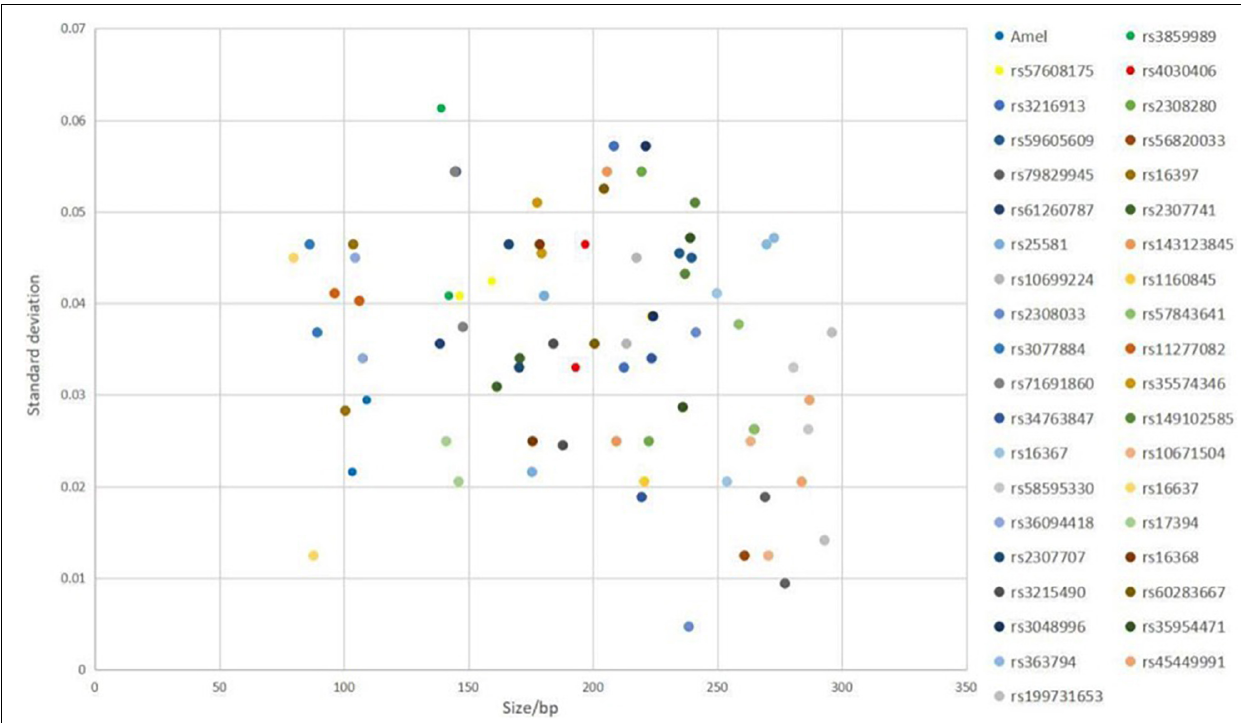
FIGURE 3 | Size precision study of AGCU X-InDel 38 kit was performed on 3130XL Genetic Analyzer. The X -axis represents the fragment sizes of all allelic ladder samples at each locus, and the Y -axis represents the standard deviation of each allele size.